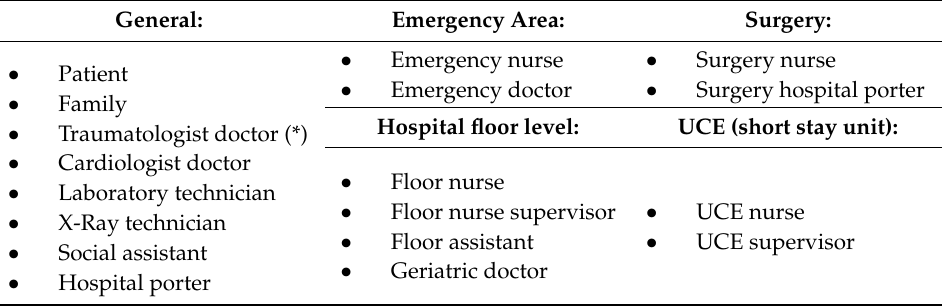
Table 2. Detail of areas and participants in hip fracture surgery